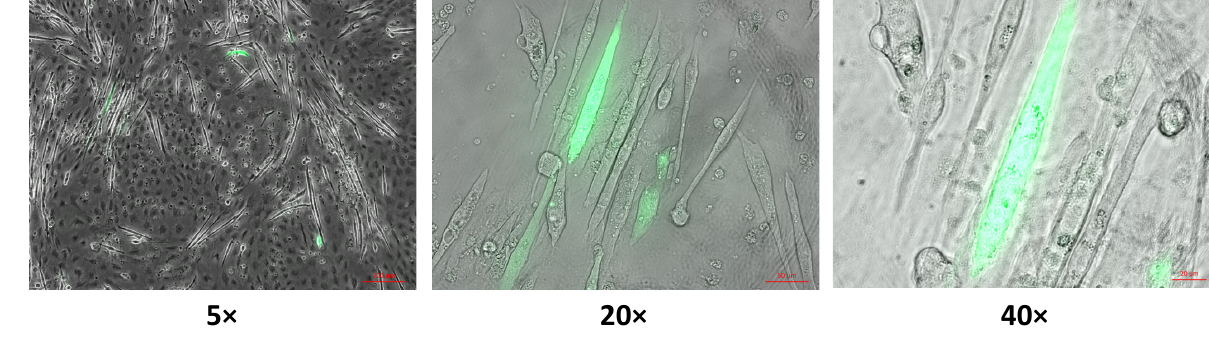
Figure 6. Cyto-Grx1-roGFP2 (cytosolic GSH/GSSG biosensor) expressed in C2C12 myotubes. Myotubes were obtained by experimental induction to differentiation of C2C12 myoblasts that already expressed cyto-Grx1-roGFP2, to myotubes. 5×, 20×, and 40× magnification of the C2C12 myotubes expressing cyto-Grx1-roGFP2. (Supplementary enlarged figures).